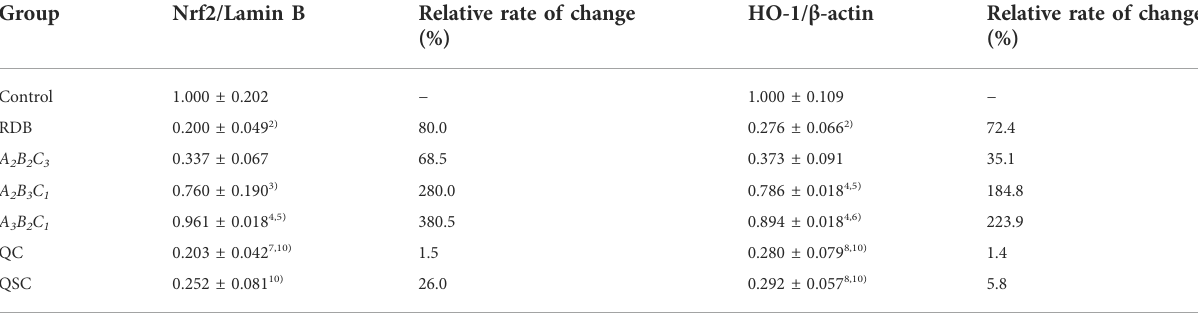
TABLE 6 Processing with ASR reversed the signi fi cantly down-regulated NQO1/GCLM pathway related proteins in liver caused by RDB. Group NQO1/ β -actin Relative rate of change Control